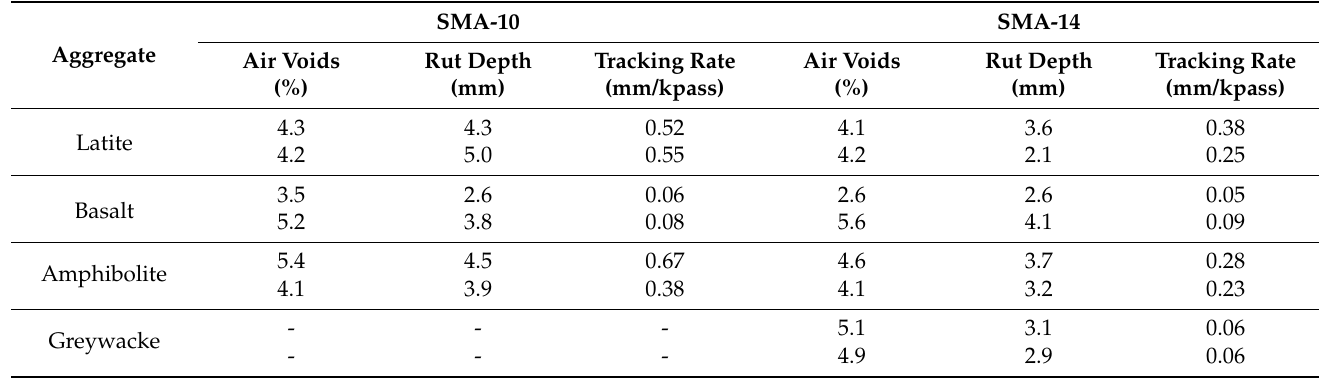
Table 9. Laboratory wheel tracking results